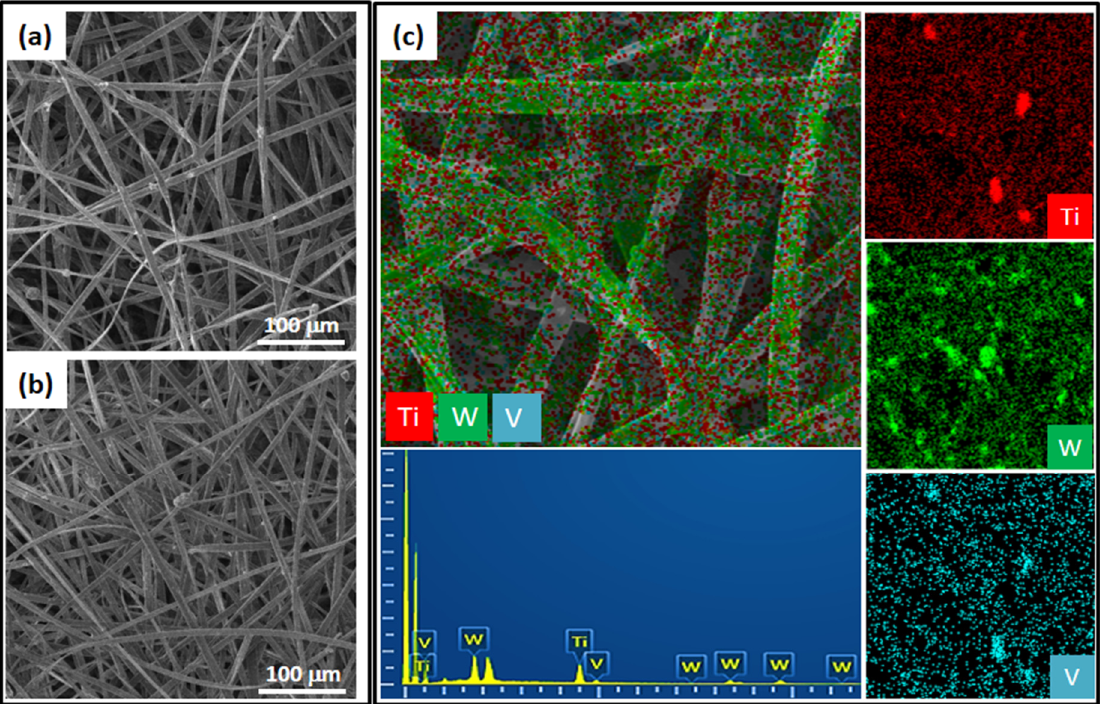
Figure 7. SEM micrographs of ( a ) TWV3 and ( b ) TWV5 MON -loaded electrospun fibers; ( c ) EDS mapping and elemental composition of V 5+ -doped samples, with indication of Ti, W, and V elements. The mean diameters of composite fibers were estimated as 5.4 ± 1.7 µ m (n = 59) [22], 5.8 ± 2.3 µ m (n = 73), and 6.0 ± 1.9 µ m (n = 69), with a progressive increase in V 2 O